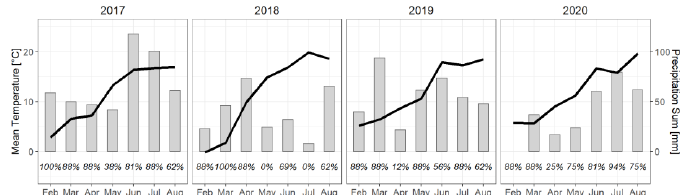
Figure A1. The weather during data acquisition at the DWD-station Kiel-Holtenau [56]. Bars indicate the monthly precipitation sum, lines the mean monthly temperature 2 m above ground, and the percent values indicated at the bottom the monthly median of cloud coverage between 10–11 a.m. (hour of Sentinel-2 overflight), measured in one eighth of the monitored sky. Table A1. Acquisition dates and data volume for the calibration of the GAI-models.